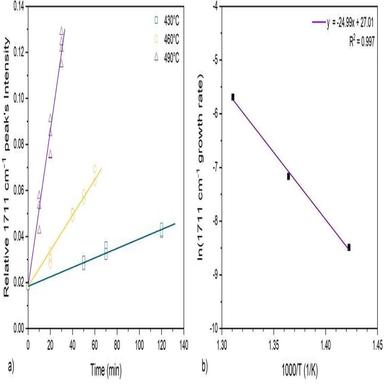
a) Growth of the 1711 cm-1 peak in CF-PEEK as a function of the exposure time at 430, 460 and 490 ◦C and b) Arrhenius plot of the 1711 cm-1 peak's growth rate when CF-PEEK is heated in static air conditions.